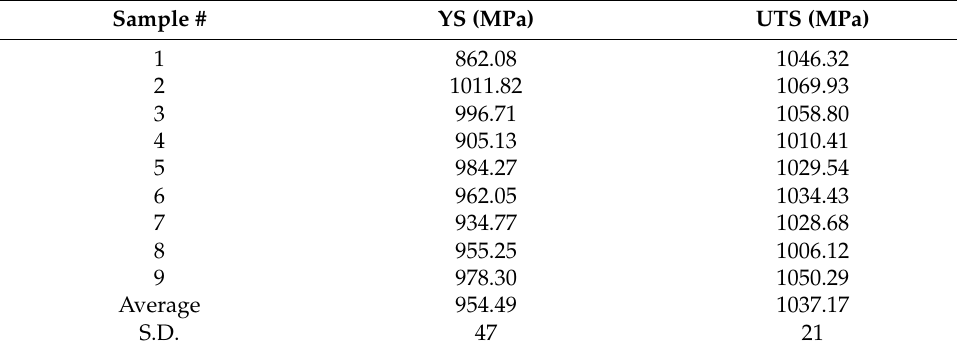
Table 3. Yield strength (YS) and ultimate tensile strength (UTS) of the repaired parts.